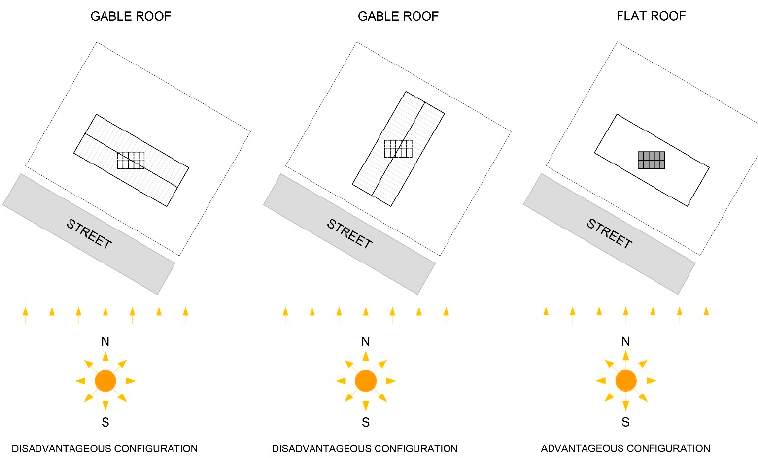
Figure 4. Possible positions of PV panels as function of an NW–SE street orientation (diagram by W. Celadyn, P. Filipek).